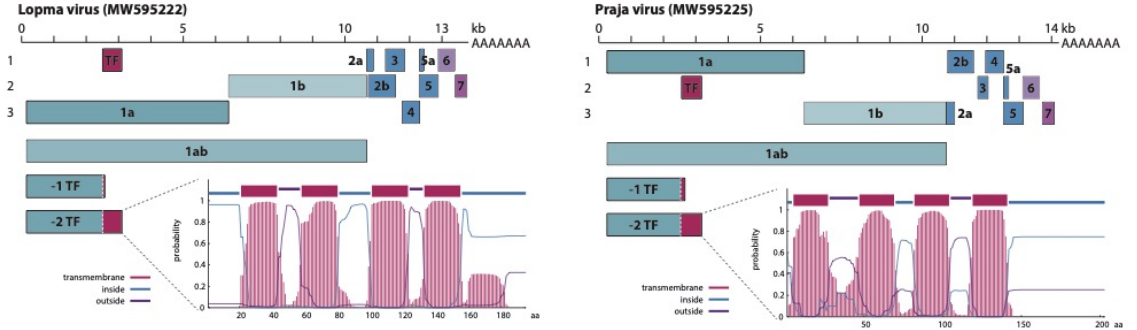
Figure 1. Genome organization of Lopma virus and Praja virus.